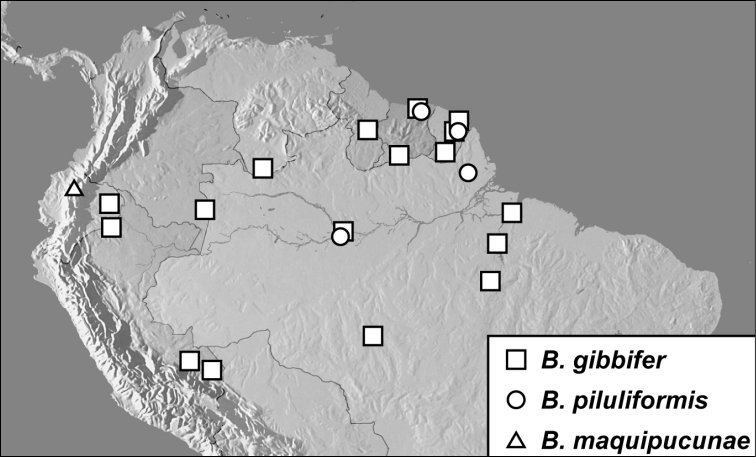
Baconia gibbifer group records.